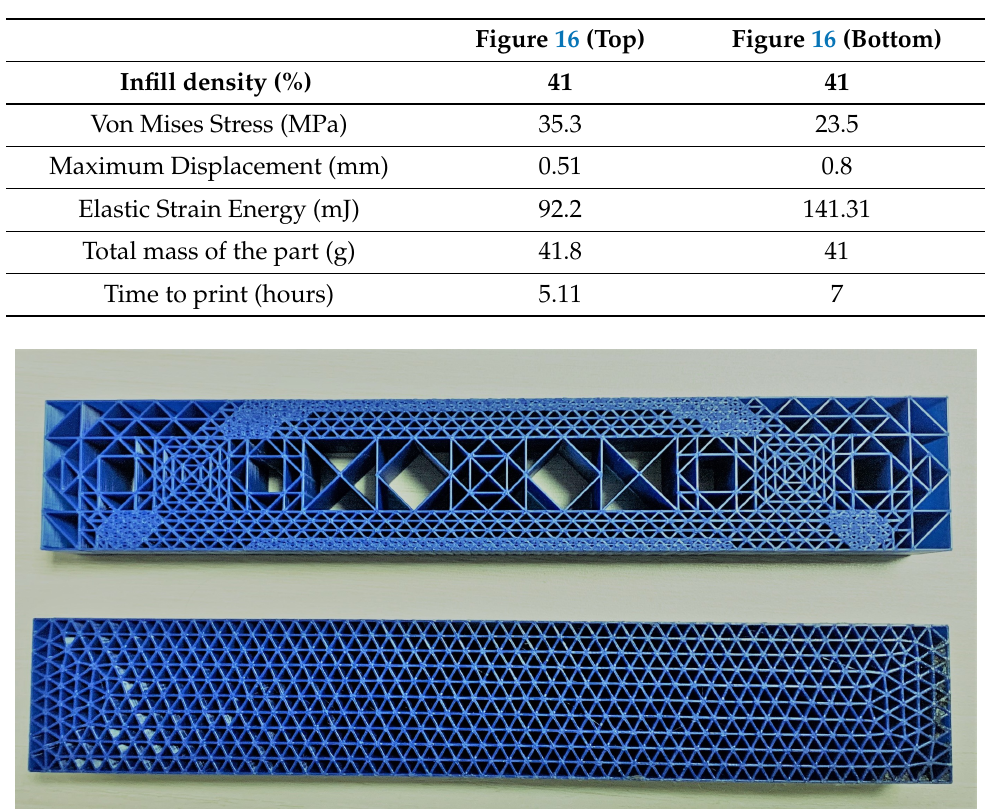
Table 6. Comparison of the part with uniform infill to the part with infill defined by refinement process using threshold stress = 10 MPa and minimum length of a side of the infill design (L) ≥ 2.4 mm as stopping criteria.